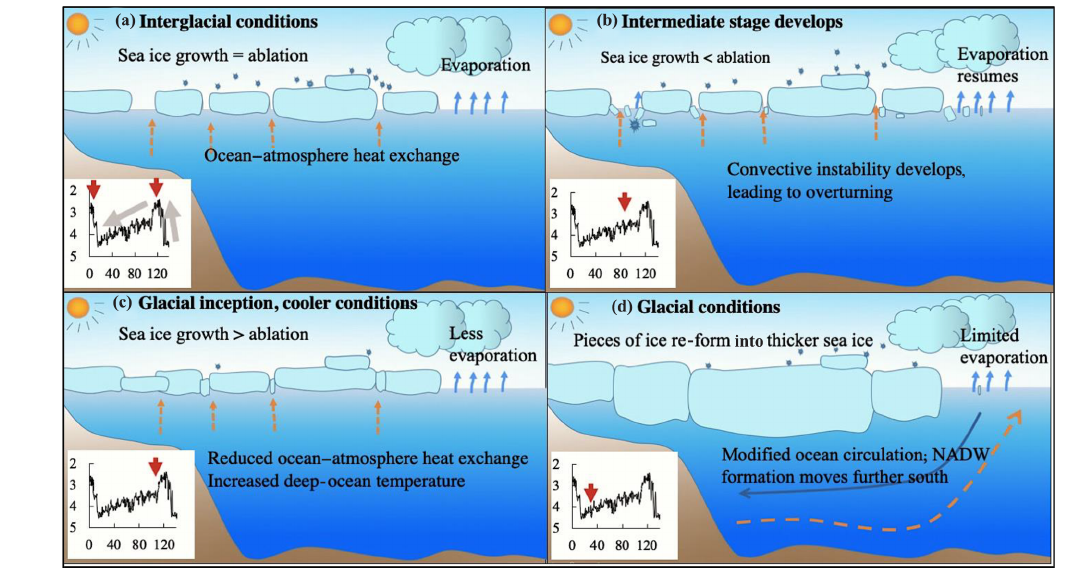
Figure 1. Illustration showing how the proposed two negative sea ice feedbacks operate to slow down the glaciation process with an inset showing benthic δ 18 O (‰) records from ODP Site 983 (Raymo et al., 2004) spanning the last 140kyr. The red arrows in the insets show the glacial transition stage described in the given panel. The grey arrows compare termination and glaciation transitions. (a) Interglacial conditions exist; there is strong exchange of energy (dashed orange arrows) and evaporation of moisture (blue arrows) from the ocean. (b) Initiation of glacial inception; sea ice extends, insulating the ocean while deep-ocean energy accumulates, increasing deep-ocean temper- atures and buoyancy eventually creating an unstable water column. (c) At some critical point, when the water column becomes sufficiently unstable there is overturning and ablation of the young sea ice, albedo decreases and temperatures increases, creating the observed interme- diary stage. (d) Sea ice has reformed due to continued cooler than interglacial conditions. This sea ice may be thicker and sturdier, better able to resist ocean turnover, leading to changes in the ocean circulation patterns instead of sea ice